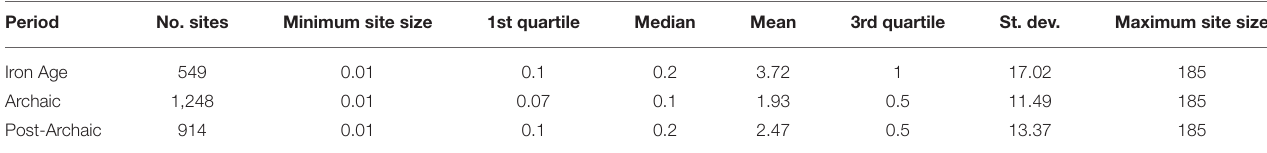
TABLE 1 | Summary of central tendency and dispersion of settlements size (ha) in Etruria. Period